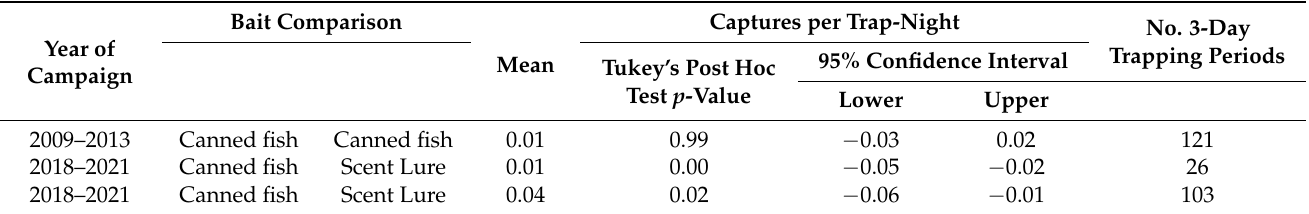
Figure 4. Comparative mean of mink trap-night using canned fish and scent lure over consecutive 3-day trapping periods (1–3; 4–6; and 7–9 days) during two trapping campaigns: 2009–2013 (data from the campaign reported by Medina-Vogel et al. [41]) and 2018–2021 (the current study). Table 2. Mean ( ± CI) mink trapped per trap-night with canned fish or scent lure, in two different campaigns. The data from 2009–2013 come from the campaign reported by Medina-Vogel et al. [41]; the 2018–2021 campaign is the current study.